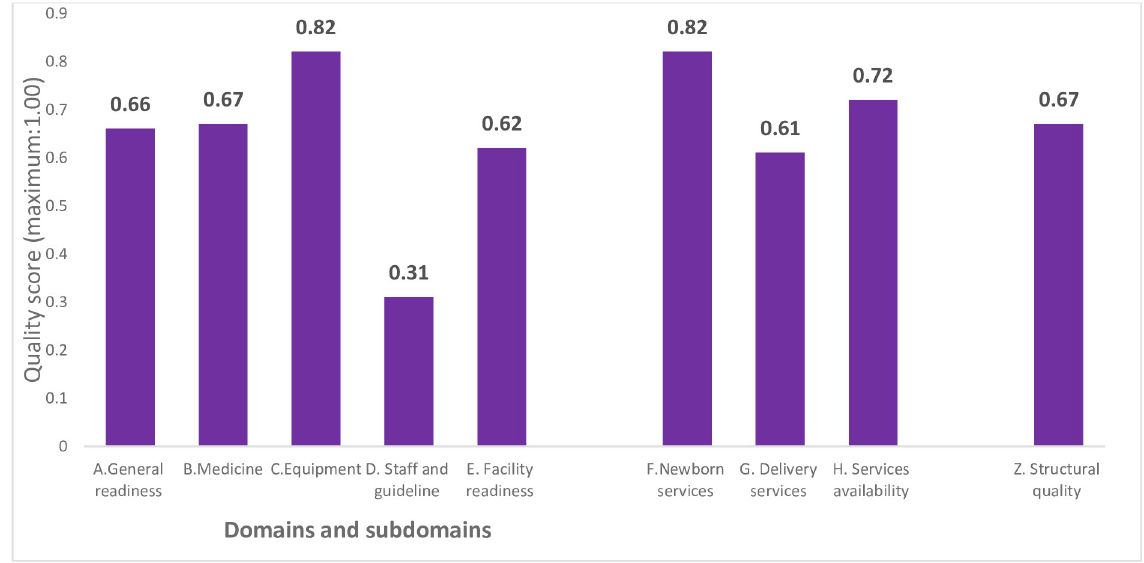
Fig 2. Structural quality score of health facilities for the perinatal